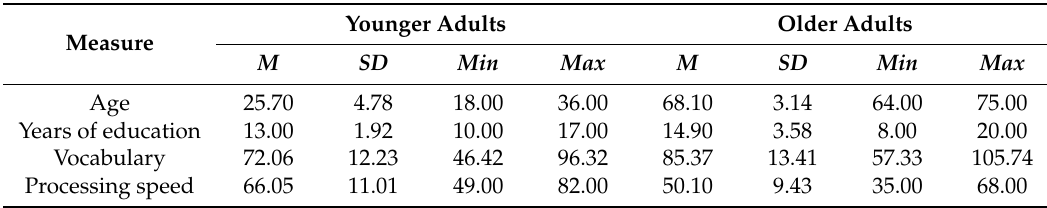
Table 1. Subject